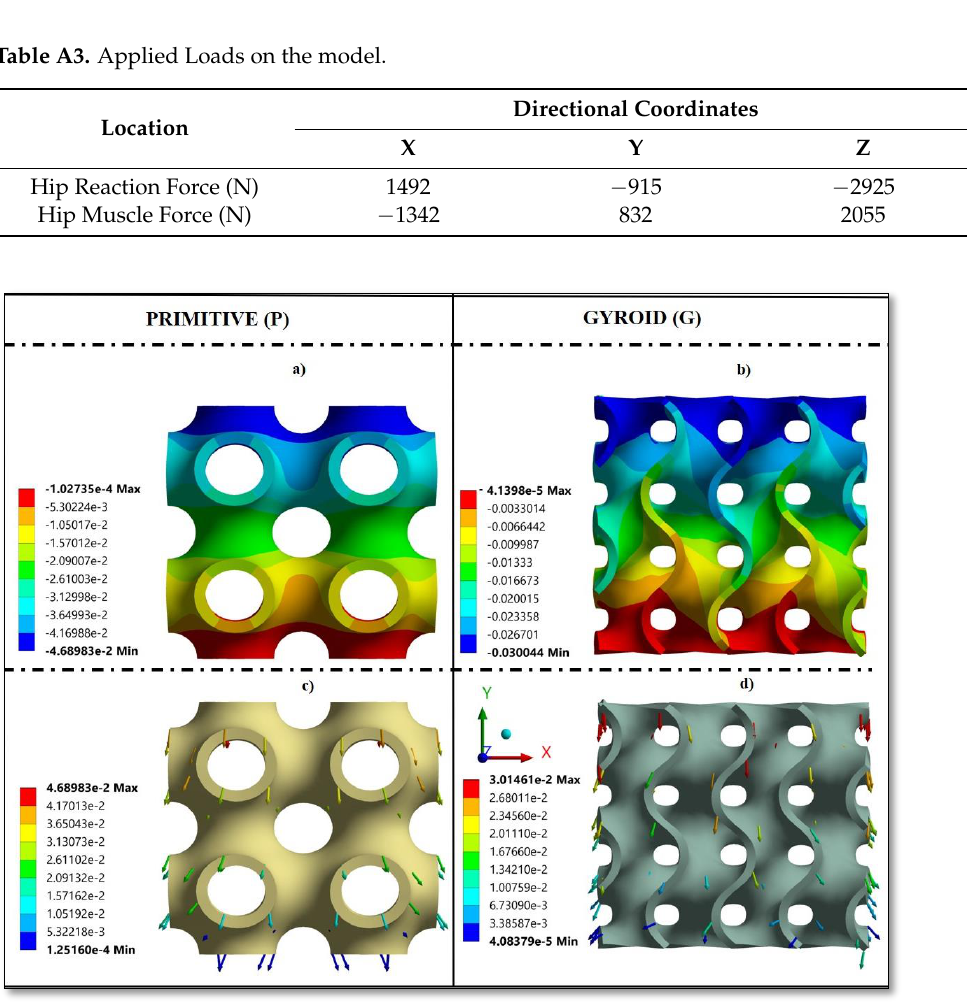
Figure A3. State of deformation along Y -axis ( a , b ), and total deformation vector display ( c , d ), of lattice structures at 80% porosity.